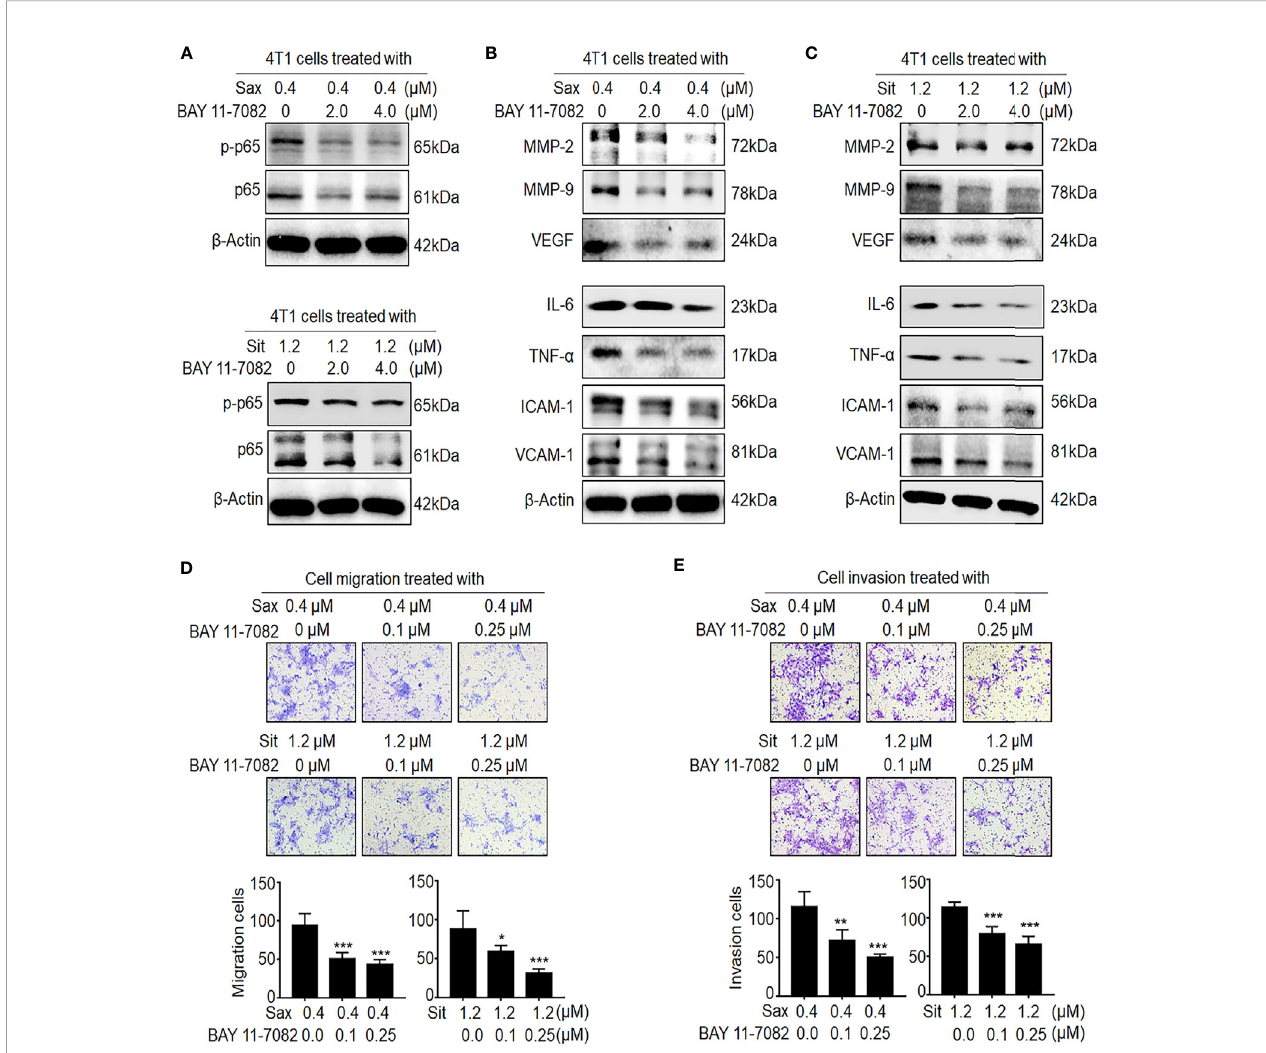
FIGURE 3 | Blockage of NF- к B activation reverses DPP-4i-driven metastasis in vitro. (A – C) NF- к B inhibitor reverses DPP-4i-driven NF- к B activation. 4T1 cells were co-treated with Sax (0.4 m M) or Sit (1.2 m M) and NF- к B inhibitor BAY 11-7082 (0, 2, and 4 m M), respectively. (A) Total p65 and p-p65 expressions and (B, C) NF- к B-responsive genes were detected by Western blotting. (D, E) NF- к B blockage attenuates DPP-4i-driven cell migration and invasion in vitro . 4T1 cells were subject to (D) cell migration and (E) cell invasion upon co-treatment with Sax (0.4 m M) or Sit (1.2 m M) and BAY 11-7082 (0, 0.1, and 0.25 m M) for 24 h. Migration or invasion cells were counted in 5 – 10 random fi elds. Data are presented as mean ± SD of three independent experiments. Representative images are shown. *p < 0.05, **p < 0.01, and ***p < 0.001 between the indicated groups determined by unpaired Student ’ s t-test or the one-way analysis of variance